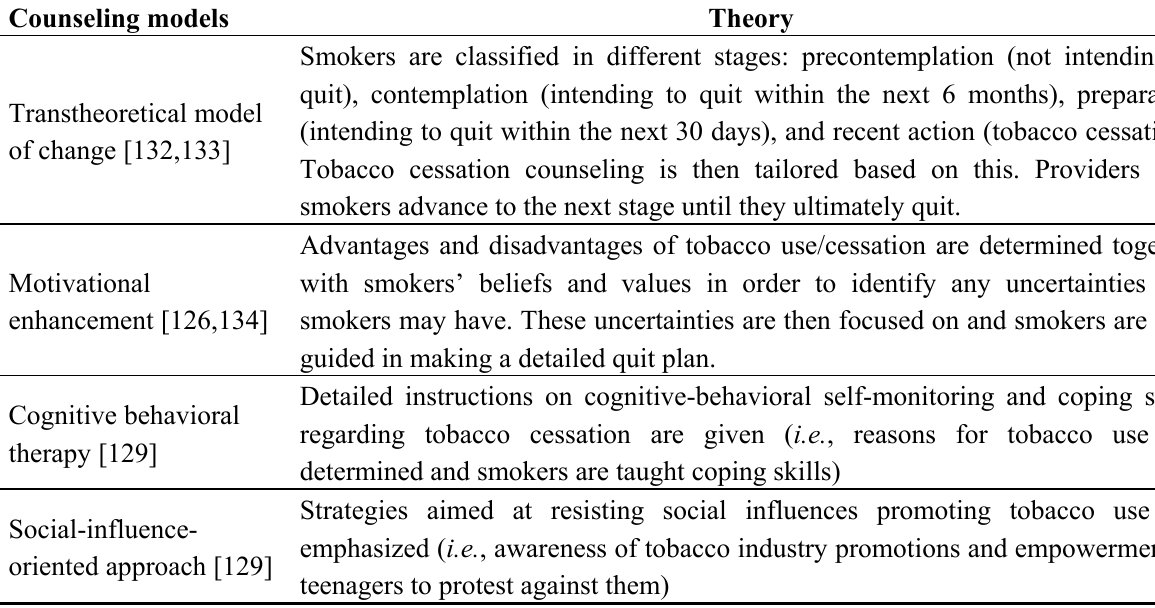
Table 4. Theoretical models used in smoking cessation